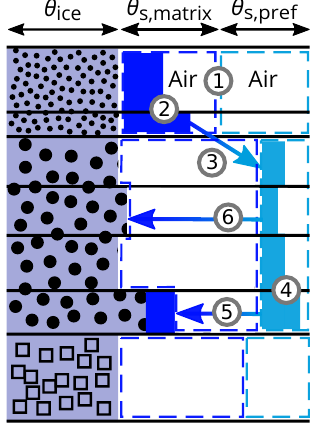
Figure 1. Schematic overview of the dual domain implementation for the SNOWPACK model, in which the pore space that can be occupied by liquid water is separated into a part for matrix flow ( θ s , matrix ) and a part representing preferential flow ( θ s , pref ). The numbers refer to processes described in the